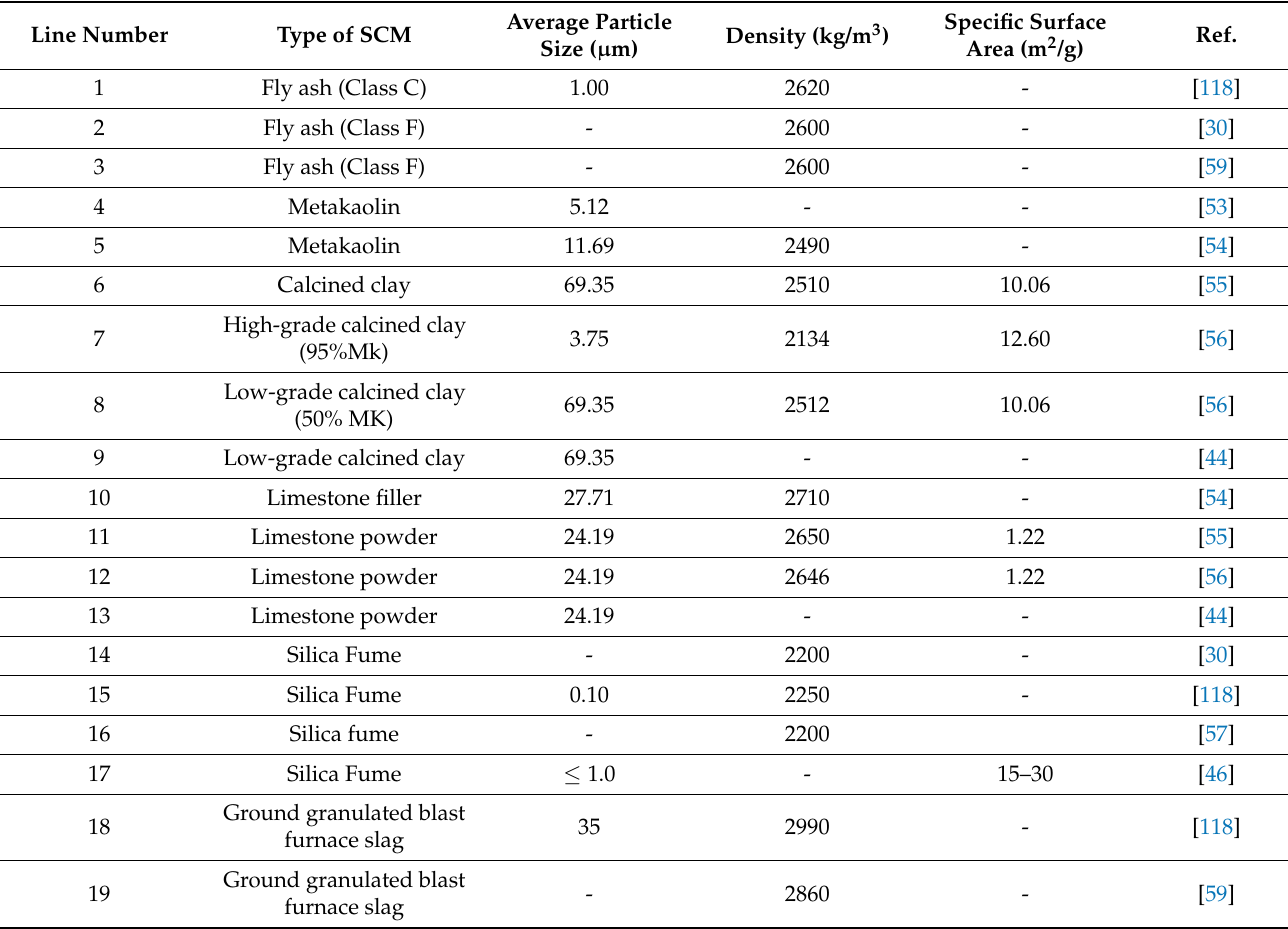
Table 2. Physical properties of different types of standard SCM used in 3DPCC